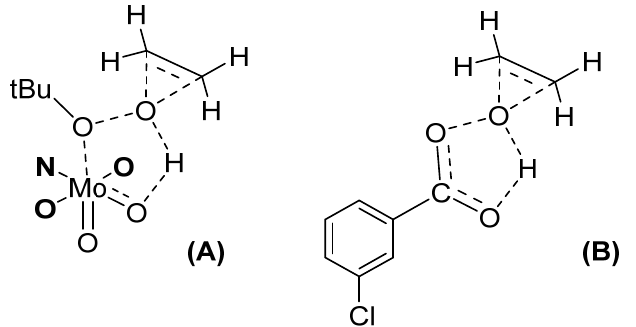
Figure 3. The transition state (TS) of olefin epoxidation using TBHP and MoO 2 (SAP) catalyst ( A ) vs. the m -CPBA postulated mechanism ( B ). For clarity of the drawing, the H 2 SAP ligand was limited to the ONO coordination sphere.